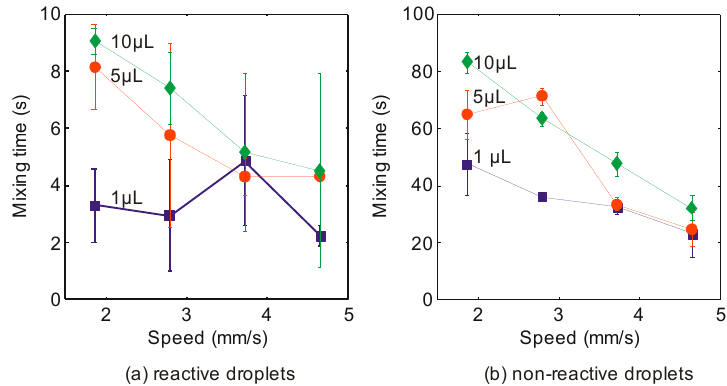
Figure 4. The y-axis represents the mixing time of ( a ) reactive droplets and ( b ) non-reactive droplets. The x-axis represents the incremental speed of the magnet (1.86, 2.79, 3.72 and 4.65 mm/s). The blue, red and green plots represent the volume (1, 5 and 10 μ L) of the droplets, respectively. The concentration of the iron oxide particles is fixed at 0.010 g/mL.